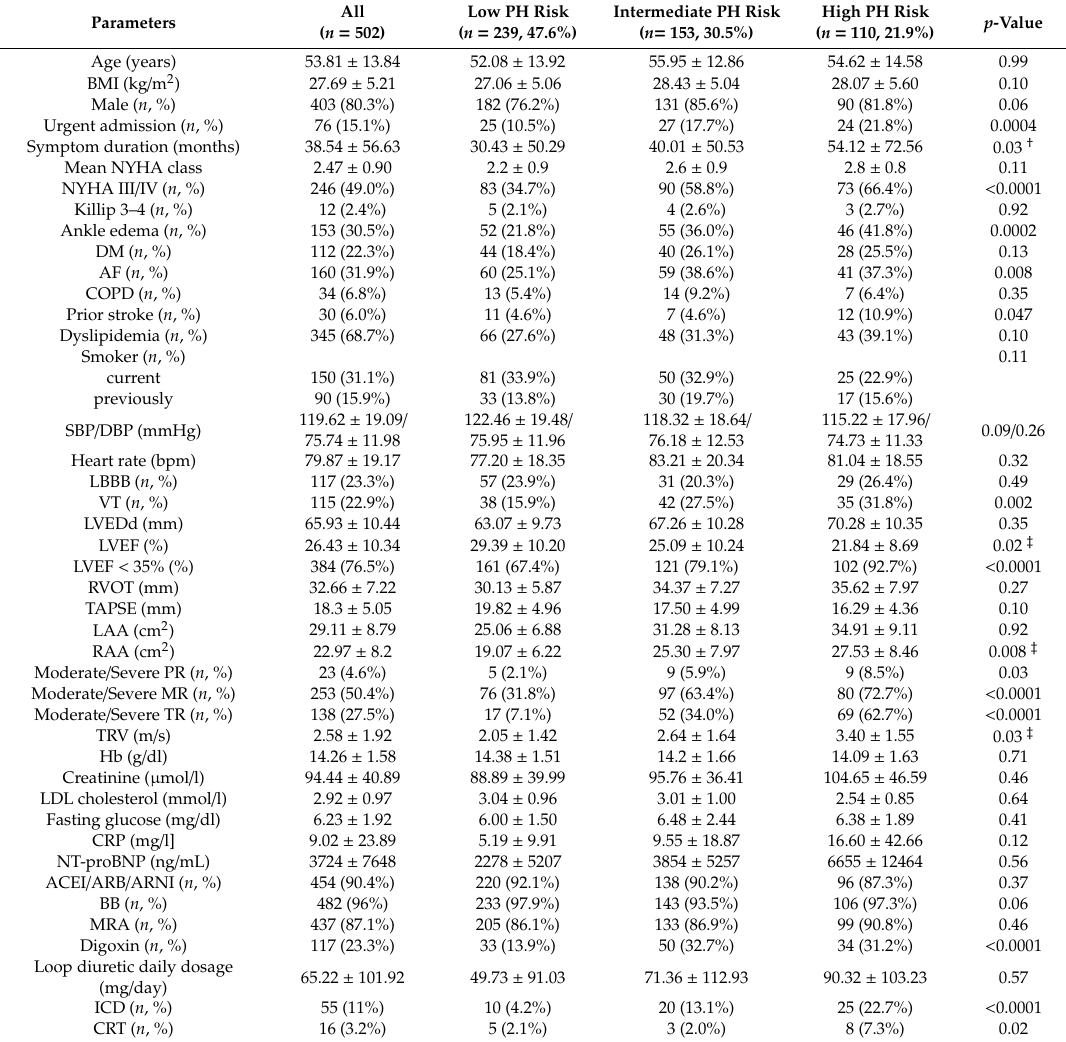
Table 1. Baseline characteristics of the study population grouped according to PH risk.